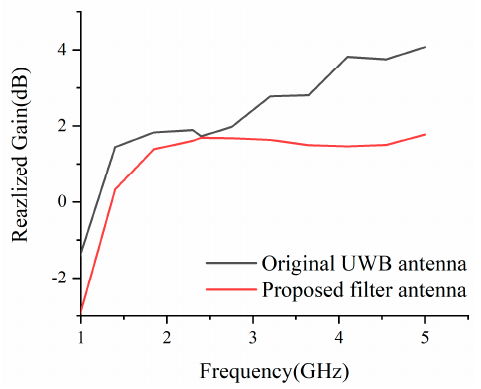
Figure 9. Comparison of the measured realized gains between the proposed antenna and the UWB antenna.